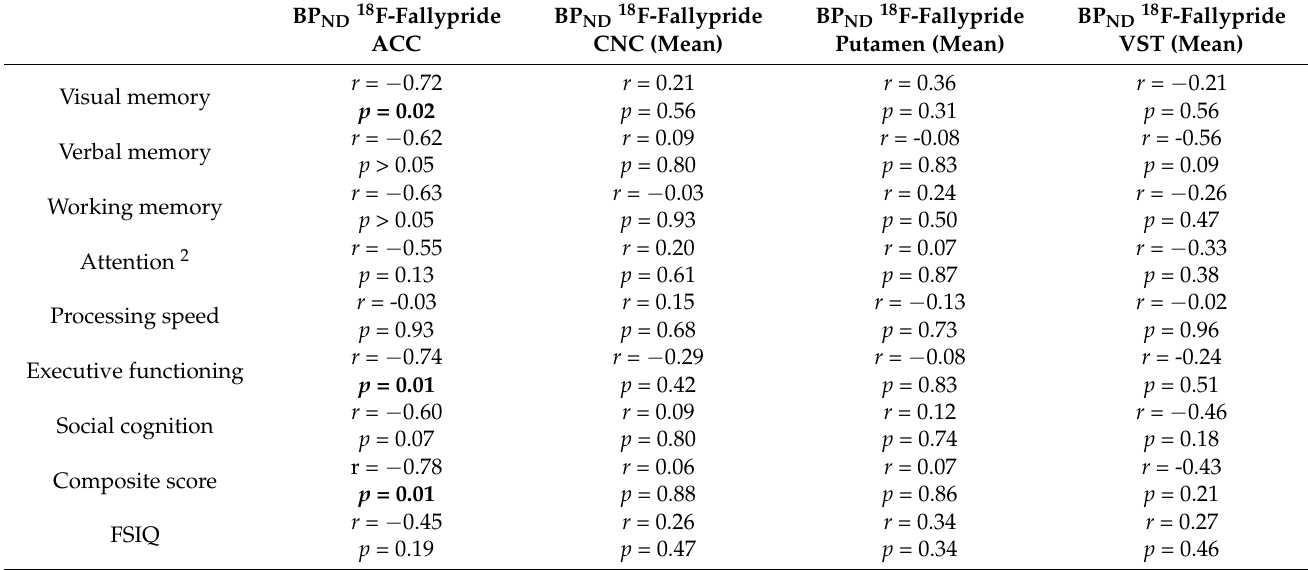
Table 4. Association between cognitive functioning and dopamine D 2/3 receptor availability